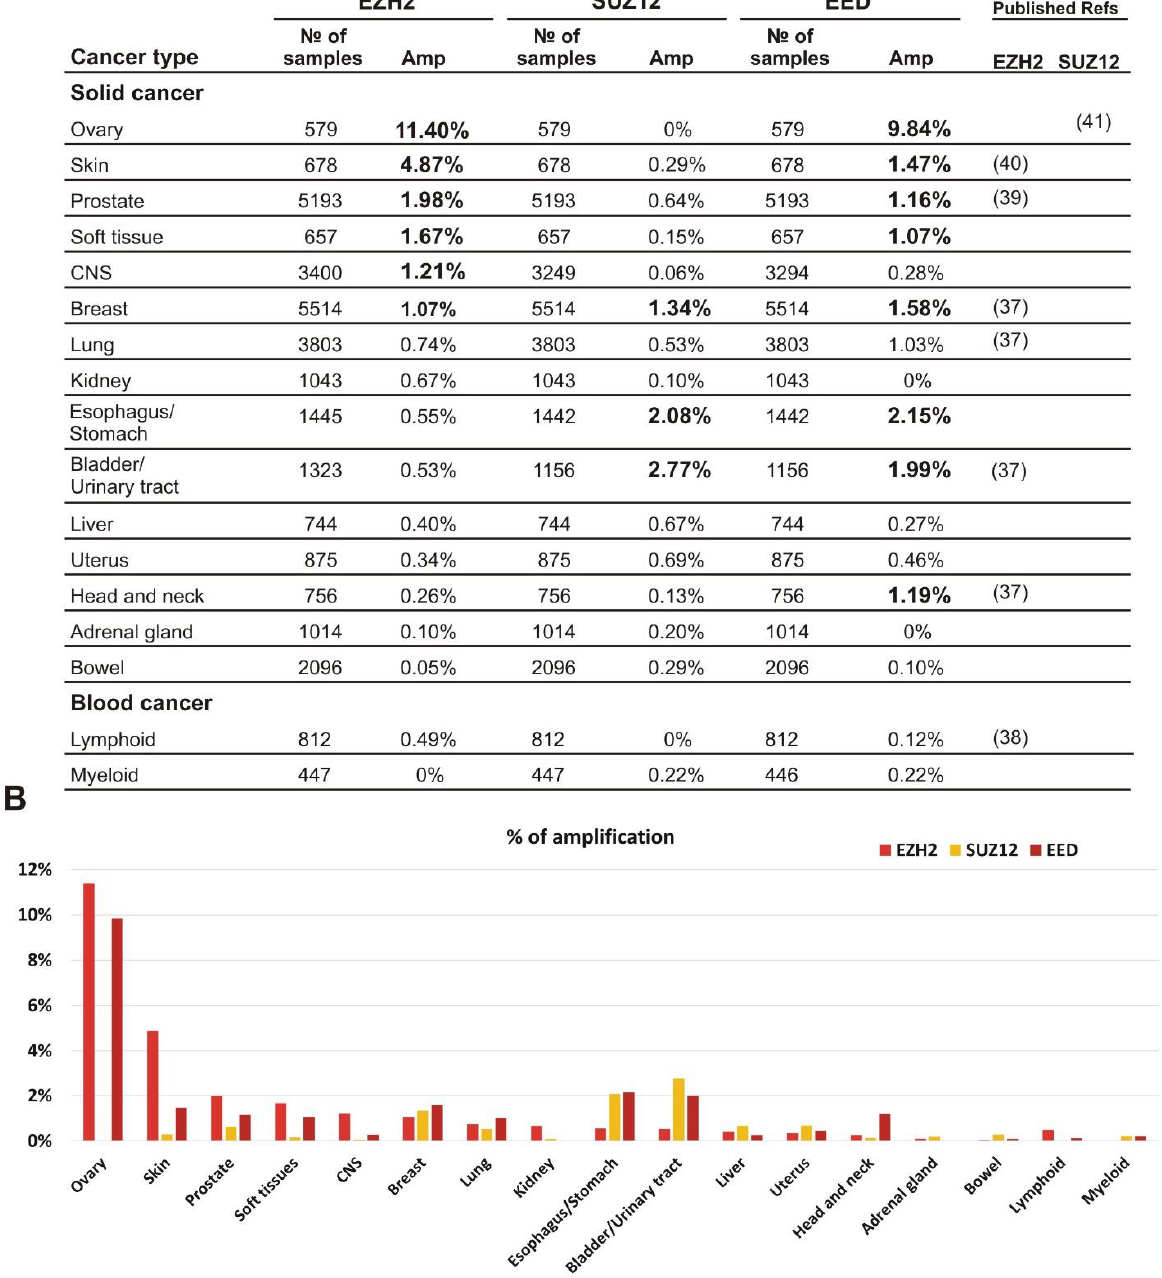
Figure 1. Amplification of EZH2 , SUZ12 and EED is frequently present in clinical cancer samples. ( A ) The analysis was performed using the cBioPortal database, which includes 185 studies and 48,045 non-overlapping samples. The cancer types containing more than 500 samples in the database are listed. The exact number of samples analyzed and the percent of cases with amplification is shown for each cancer type. All values above 1% are shown in bold; for convenience. The references to previous studies identifying amplification for EZH2 or SUZ12 are indicated on the left. ( B ) Graphical representation of EZH2 , SUZ12 and EED frequencies of the